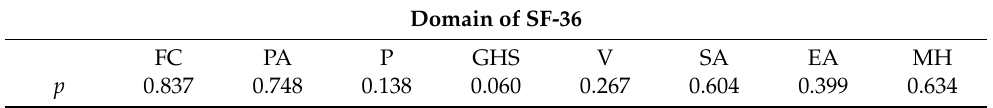
Table 4. p -Values obtained when comparing the distributions of scores in the two groups in each SF-36 domain.